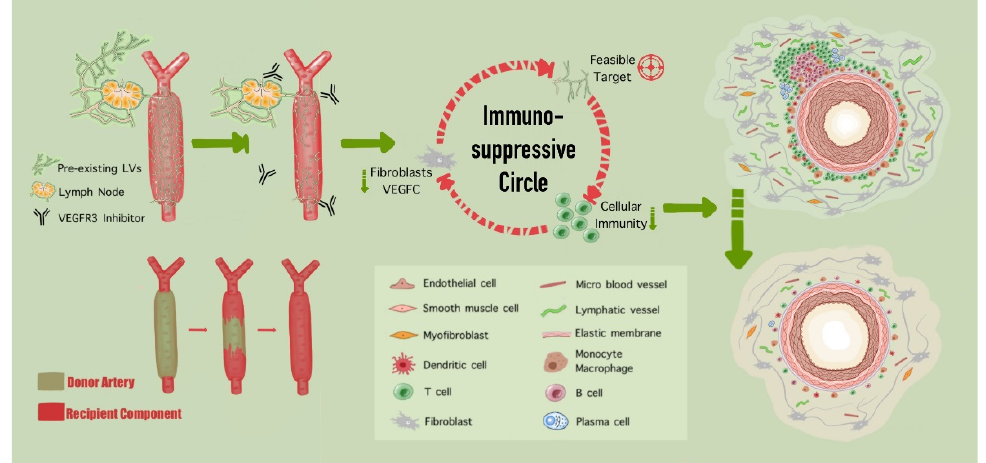
Figure 5. The impact of lymphangiogenesis in transplant arteriosclerosis. After vascular transplantation, the immediate recognition of donor artery components progressively induces immunological rejection response. After injecting a highly selective inhibitor for VEGFR3, the inhibition of lymphangiogenesis effectively suppresses the cellular adaptive immunity, and further ameliorates neointimal hyperplasia, adventitial fibrosis, and teritary lymphoid organs’ (TLOs) formation in vascular allografts. Resultantly, an immunosuppressive circle was reasonably achieved by the negative lymphangiogenesis manipulating.